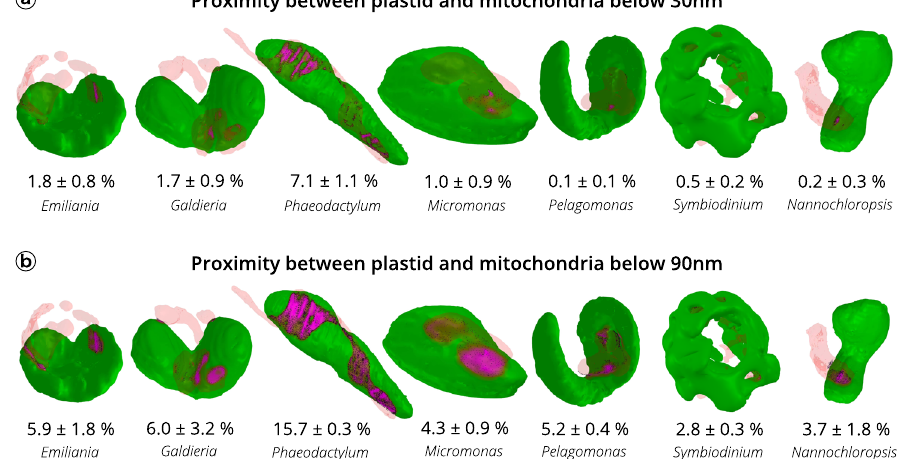
Fig. 4 Proximity between plastids and mitochondria in different phytoplankton members. Green: plastid surface. Red: mitochondria surface. Magenta: proximity surface (i.e. points at a distance ≤ 30 nm (panel a ) or ≤ 90 nm (panel b ) between mitochondria and plastids. Data refer to three cells ± s.d. for every species.